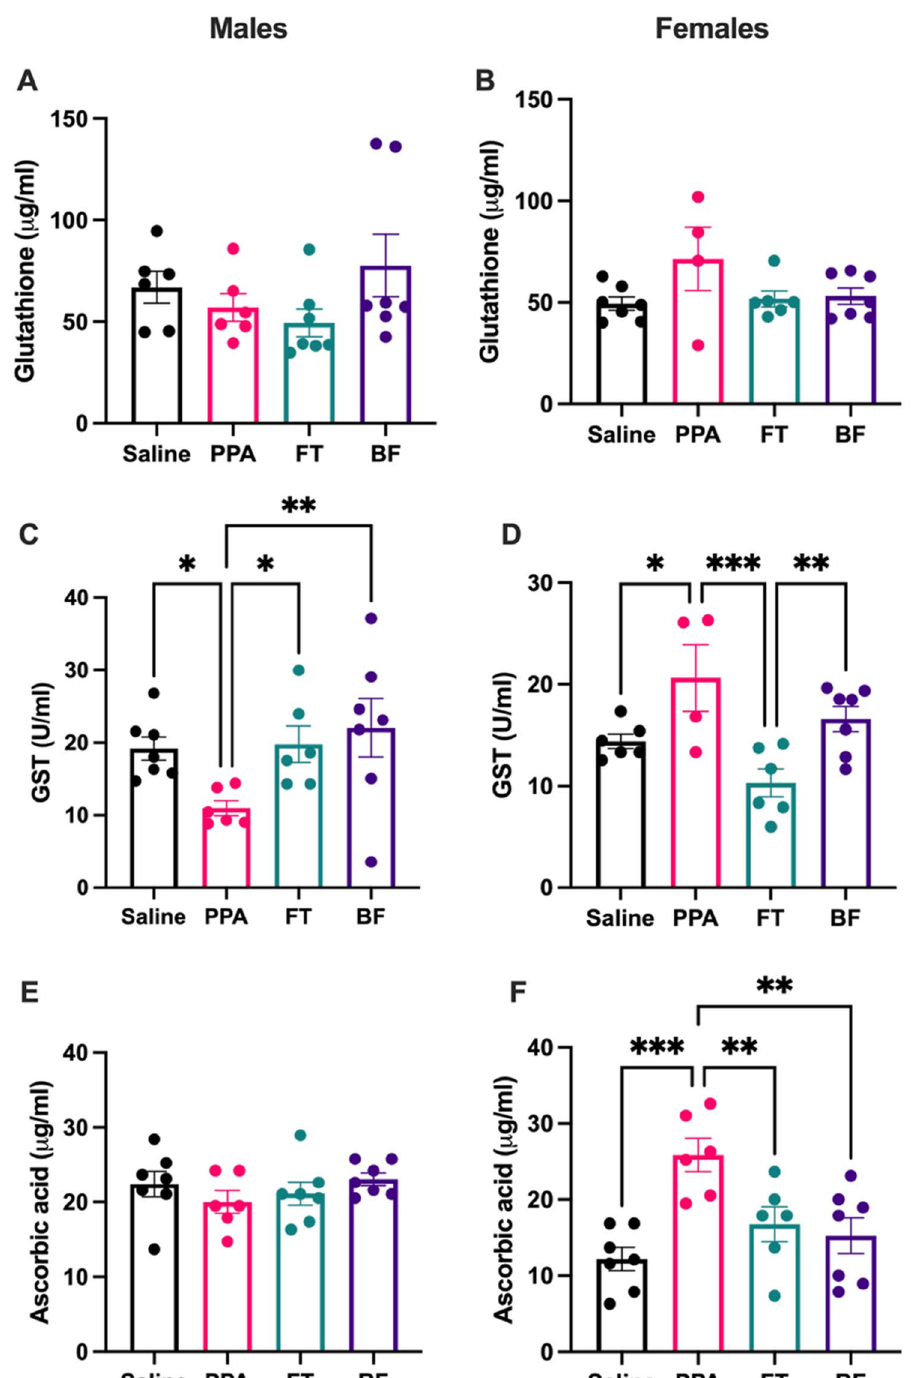
Figure 4. Testing the predictive power of five biomarkers using receiver operating characteristic curve. Areas under the curve (AUC) and p values are indicated. Analysis was performed on ASD (n = 40) and healthy (n = 40) volunteers. PC1: first principal component scores computed in principal component analysis. Disc1: first discriminant scores computed in discriminant analysis. PProb predicted probability computed by binary logistic principal component analysis. Figure was generated using IBM SPSS Statistics for Windows, Version 27.0, IBM Corp., Armonk, New York, https:// www. ibm.